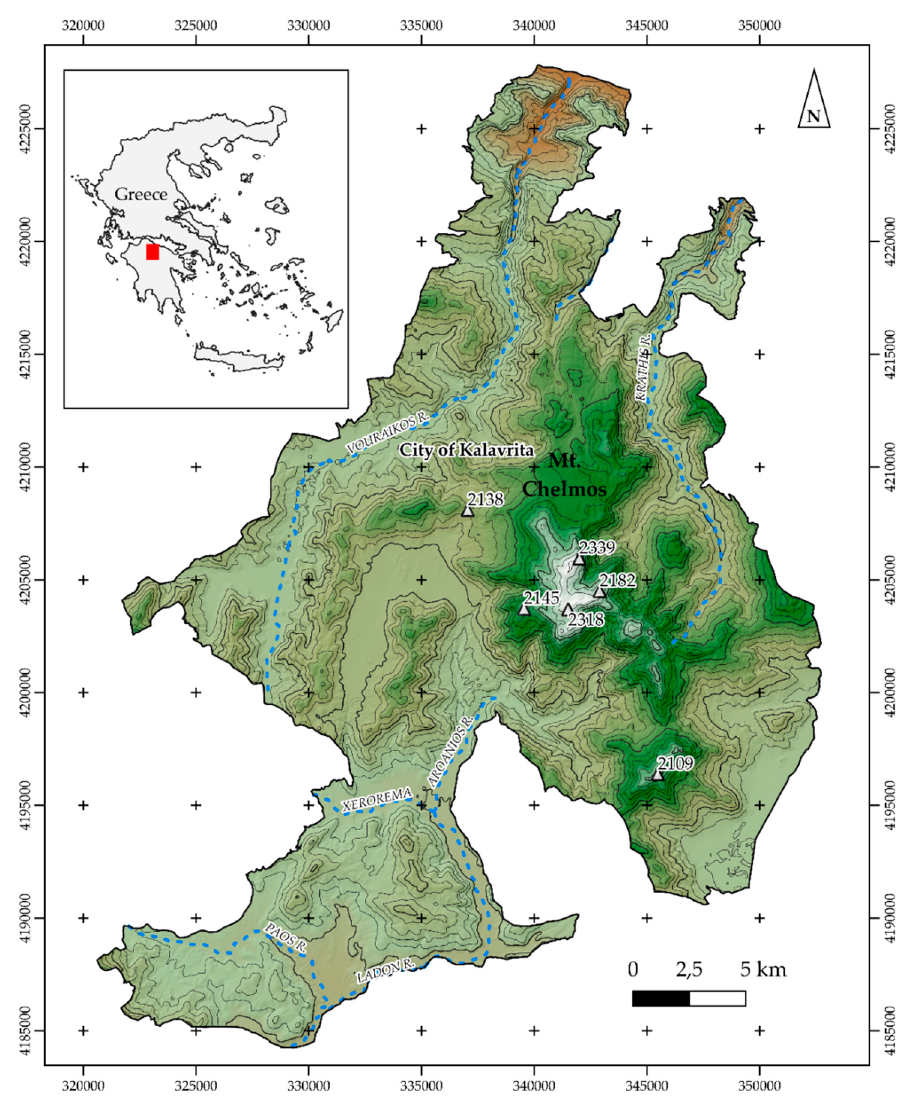
Figure 1. Map of the study area depicting the largest city of the area (Kalavrita), major rivers, and mountain peaks above 2000 m. Contours correspond to 100 m intervals; contours with thicker lines correspond to 500 m intervals.